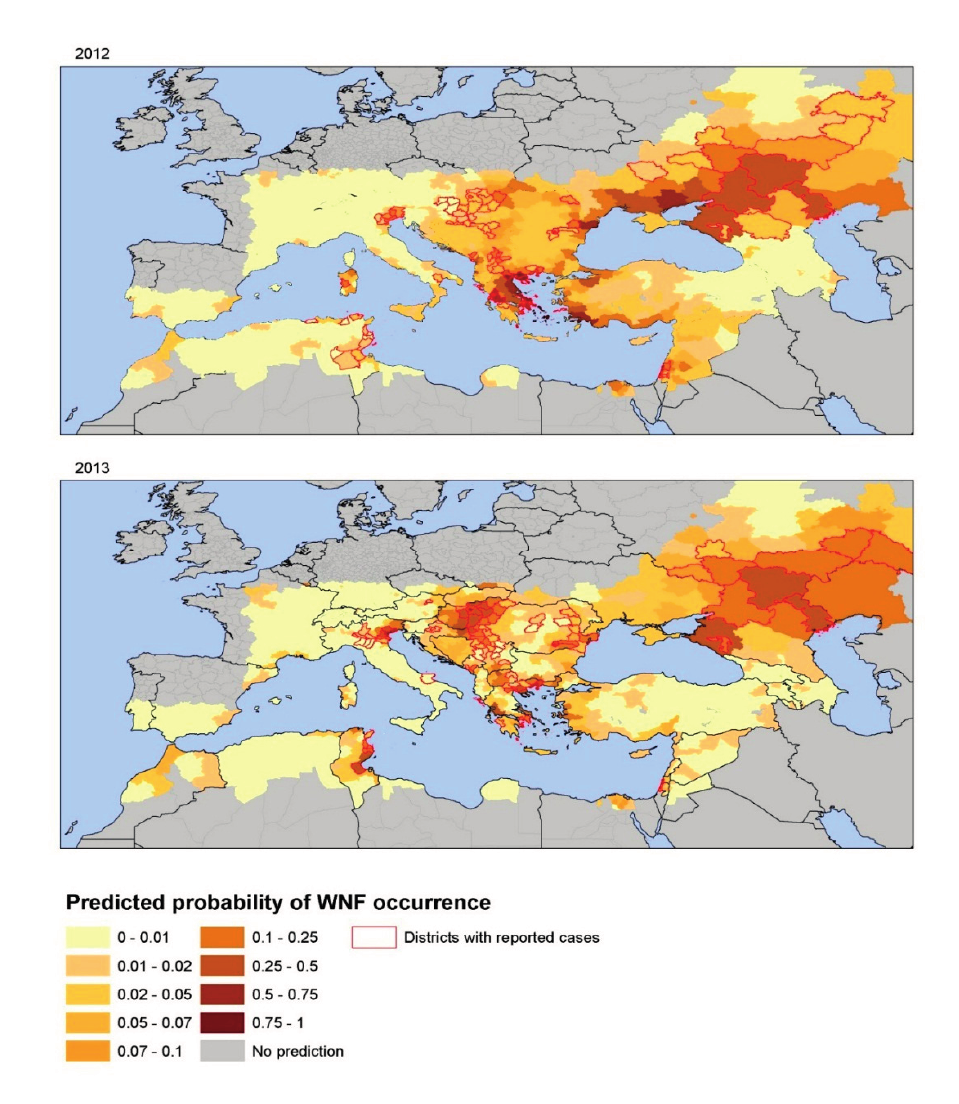
Figure 6. Map of predicted probability of WNV infection based on environmental predictors, Europe and neighboring countries, 2012 and 2013. Note: Reprinted with permission from